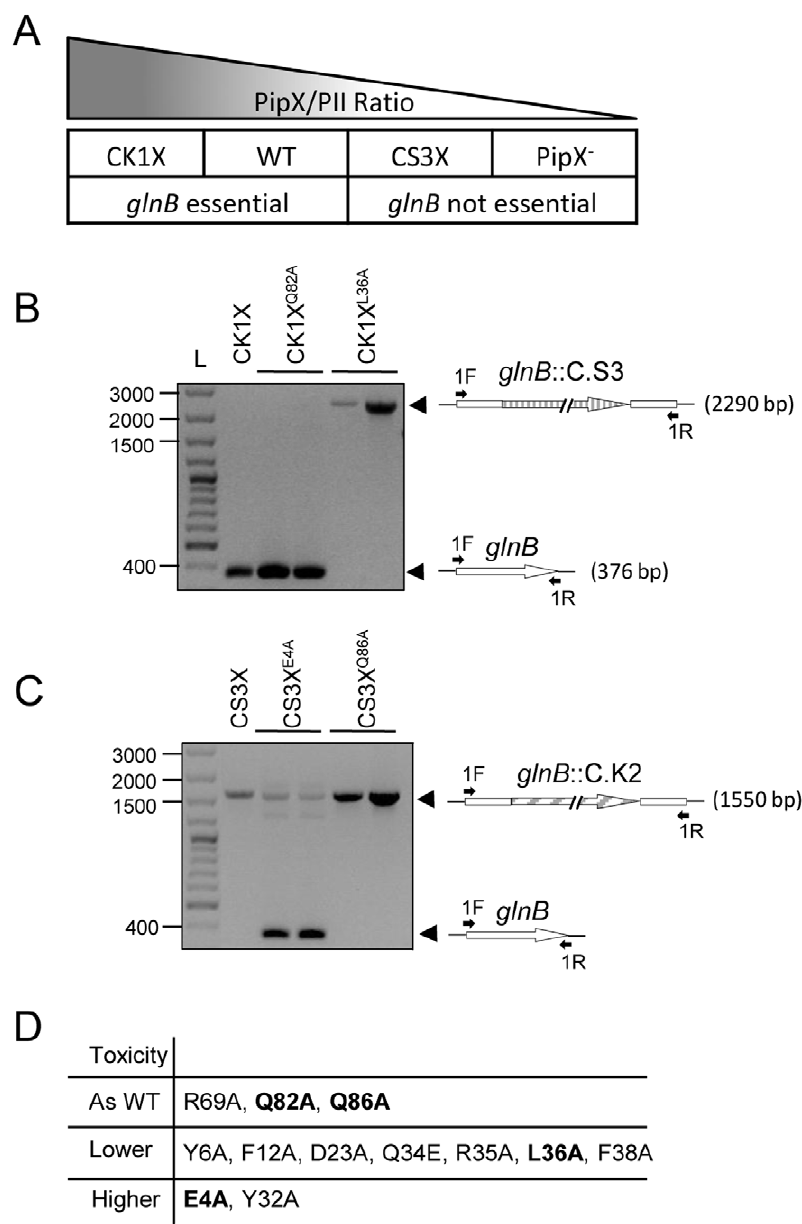
Figure 3. Effect of pipX mutations on toxicity. (A) Cartoon illustrating the correspondence between different genetic backgrounds for pipX and the PipX/P II ratio (triangle) decreasing from left to right. PCR analyses for detection of glnB alleles in CK1X (B) and CS3X (C) strains and derivatives. Transformant clones of the indicated strains carrying compatible C.K1 or C.S3 insertions in glnB were analyzed by PCR after three consecutive transfers onto selective media. Two independent clones for each selected point mutation derivative are shown. Positions of PCR products are indicated to the right. The corresponding wild type ( glnB ) and mutant alleles ( glnB ::C.S3 and glnB ::C.K2) are schematically represented with indication of the positions of the PCR primers used (black arrows). Lane L, size marker (GeneRuler 100 bp plus DNA ladder, Fermentas). (D) Classification of PipX substitutions into three toxicity levels based in the PCR analysis. Substitutions indicated in bold type correspond to the representative examples illustrated in B and C.